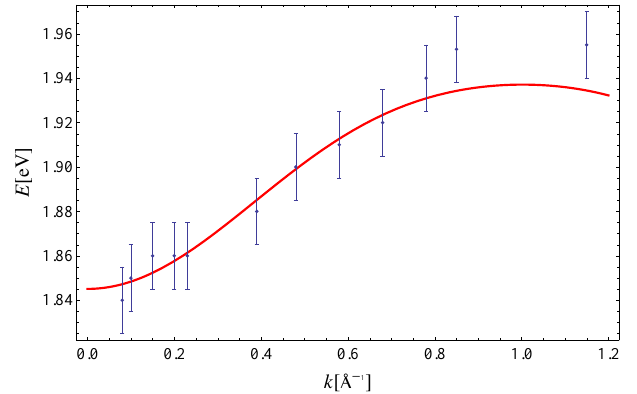
Figure 8. Exciton dispersion along the ( 100 ) direction. Experimental data are taken from Reference [10]. The theoretical curve is obtained for: ∆ = 1.90 eV [33], I x